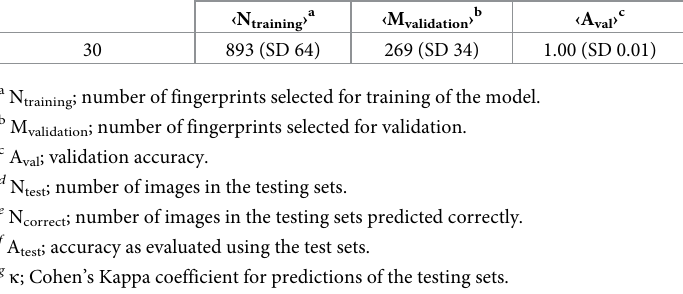
Table 6. Classification of Abs (ADI-15734 and ADI-15878) recognizing two epitopes at the base of the EBOV-GP trimer. We colored the fingerprints for the DNN models according to the charge coloring code. No. DNN